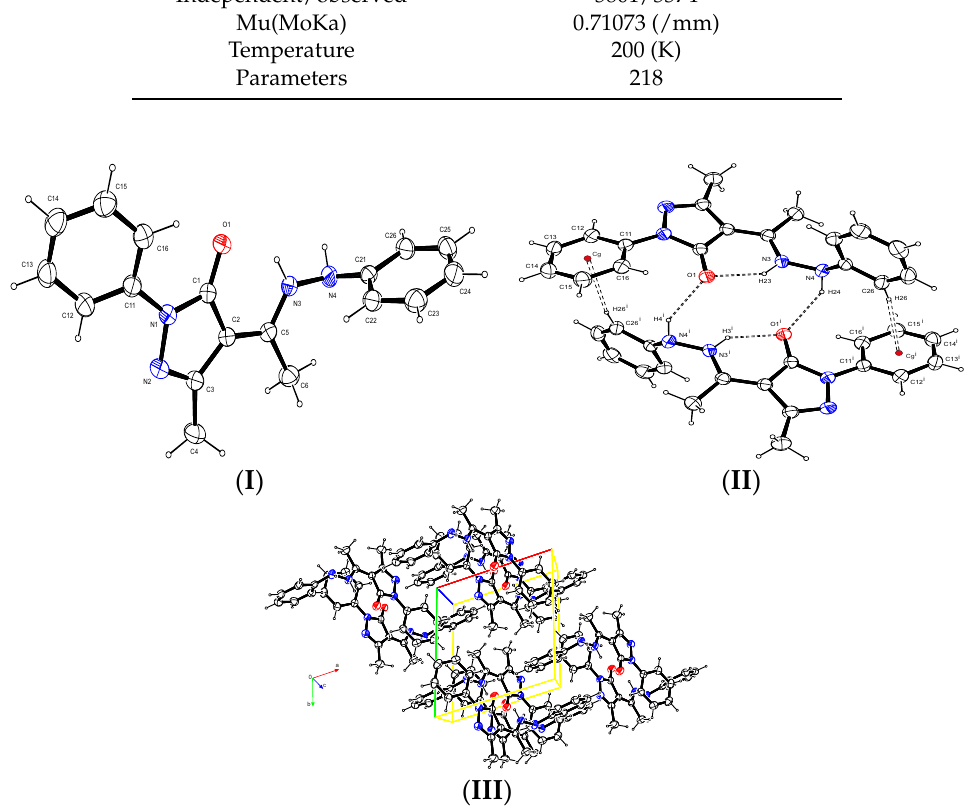
Figure 8. X-ray crystal structures: ( I ) Ortep diagram of the titled compound with thermal ellipsoids drawn at 50% probability level; ( II ) hydrogen interactions; for clarity the π … π ring interaction is not shown. Cg is the centroid of the C11–C16 phenyl group, Symmetry element (i) 1-x, -y, 1-z; and ( III ) packing diagram of Ampp-Ph. The coloured lines are the unit cell axis orientation and the red and blue circles represent oxygen and nitrogen respectively.